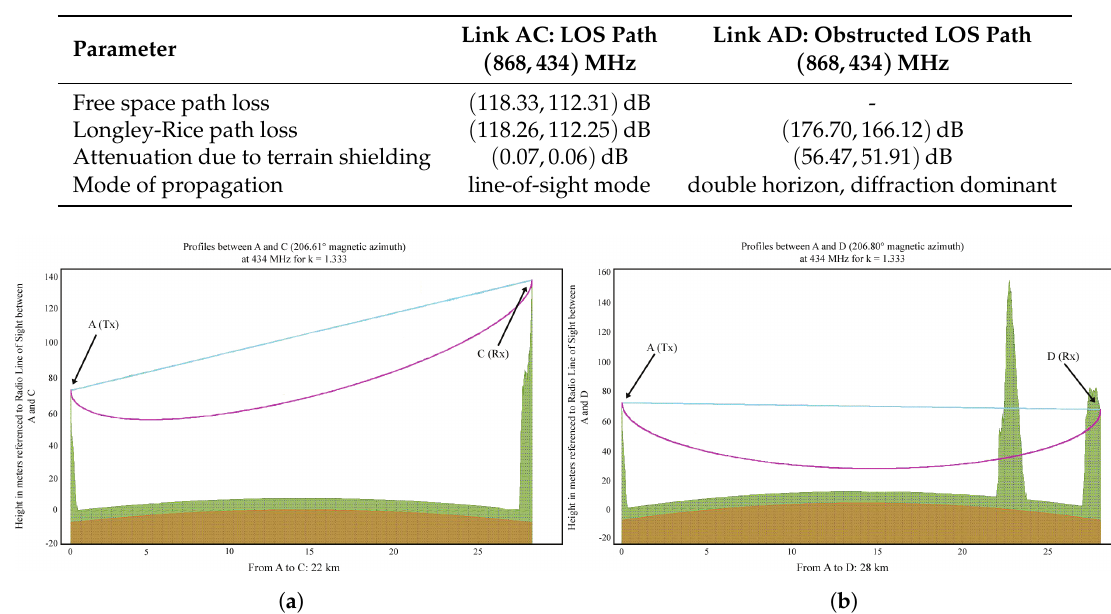
Figure 4. Map showing line-of-sight trajectory (A–C) and obstructed trajectory (A–D). Table 2. BotRf simulation results for 868MHz and 434MHz.